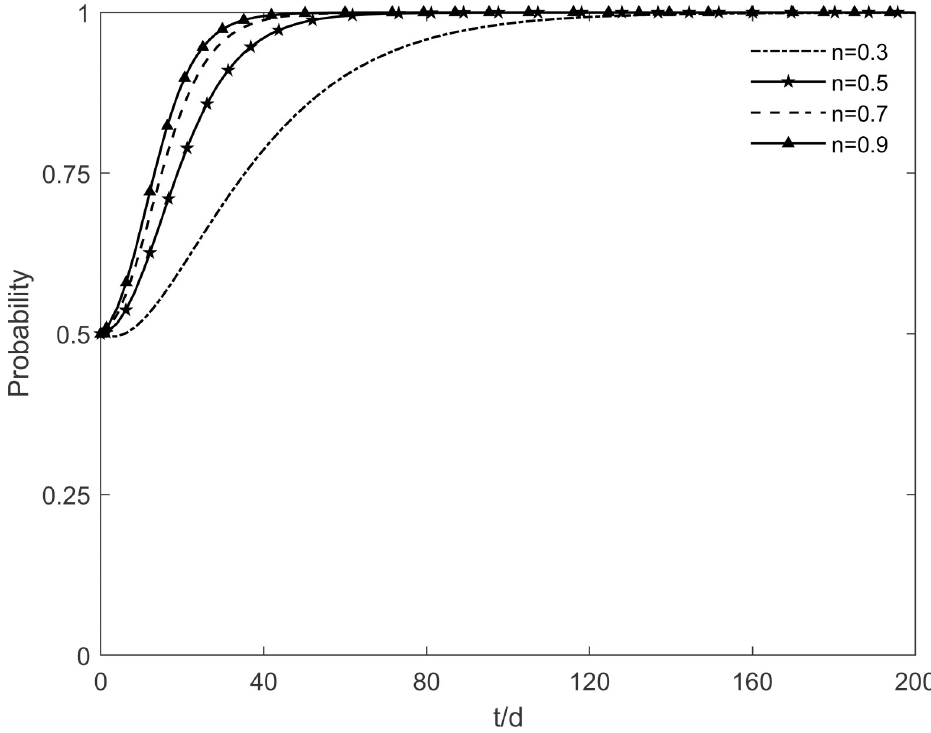
Fig 13. The impact of n on the investment retrofitting enterprises’ strategic choices.